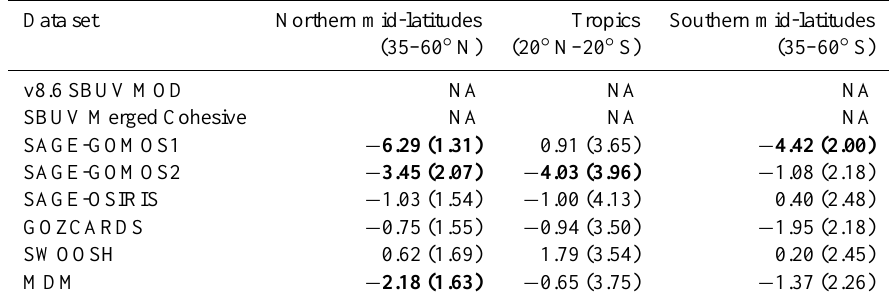
Table 13. As for Table 11 but for 50hPa. Trends were not calculated for the SBUV data sets at pressures greater than 20 and 30hPa in the tropics and mid-latitudes, respectively, therefore they are not shown